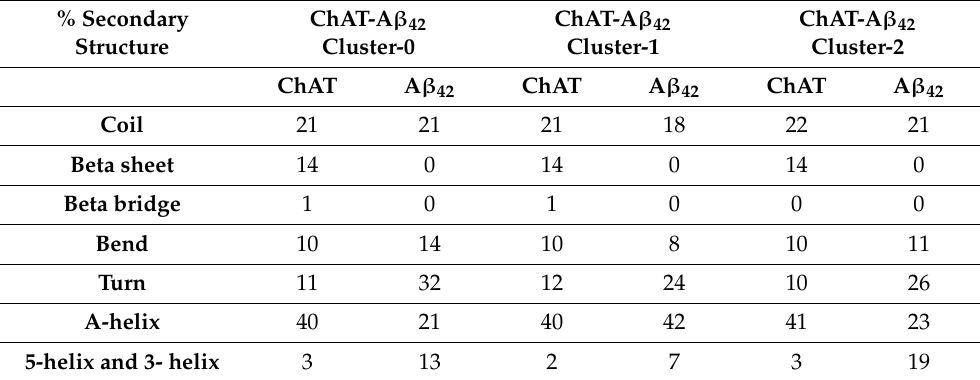
Table 3. Average secondary structure across the trajectory clusters of A β 42 on